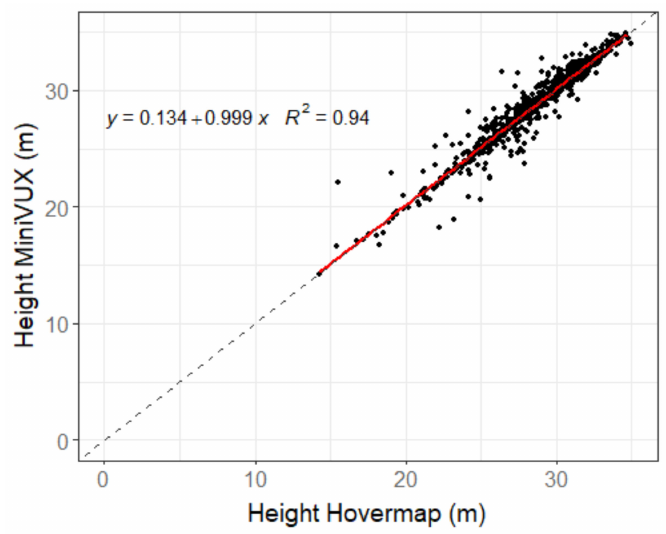
Figure 15. Correlation between ULS- and MLS-derived heights. The dashed line represents a 1:1 line and the red line represents a fitted linear model with the linear equation and R 2